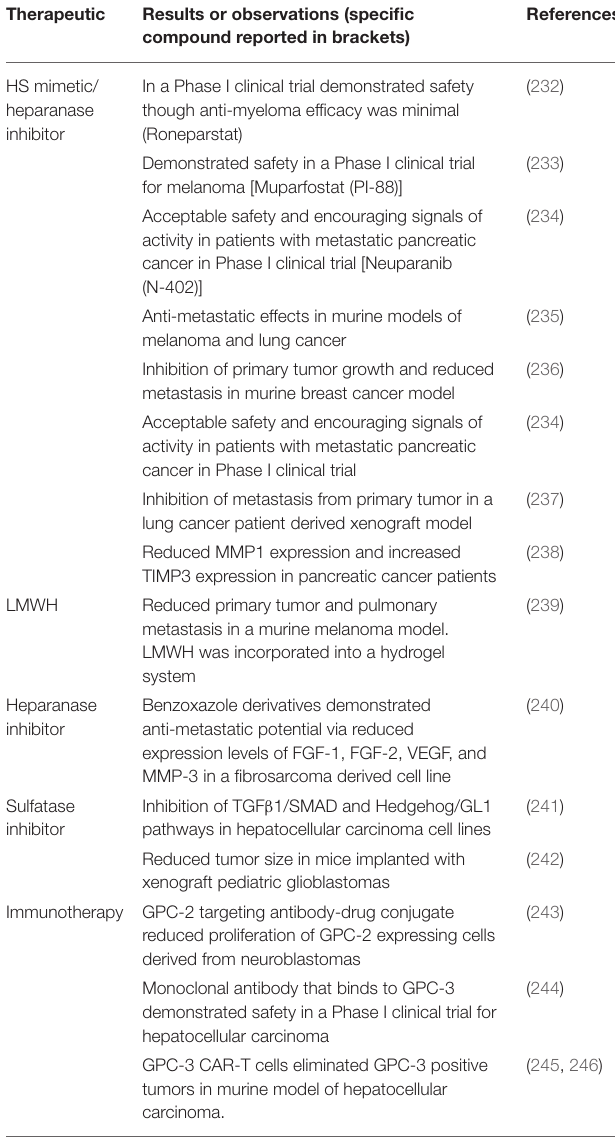
TABLE 2 | Summary of therapeutics that target heparan sulfate